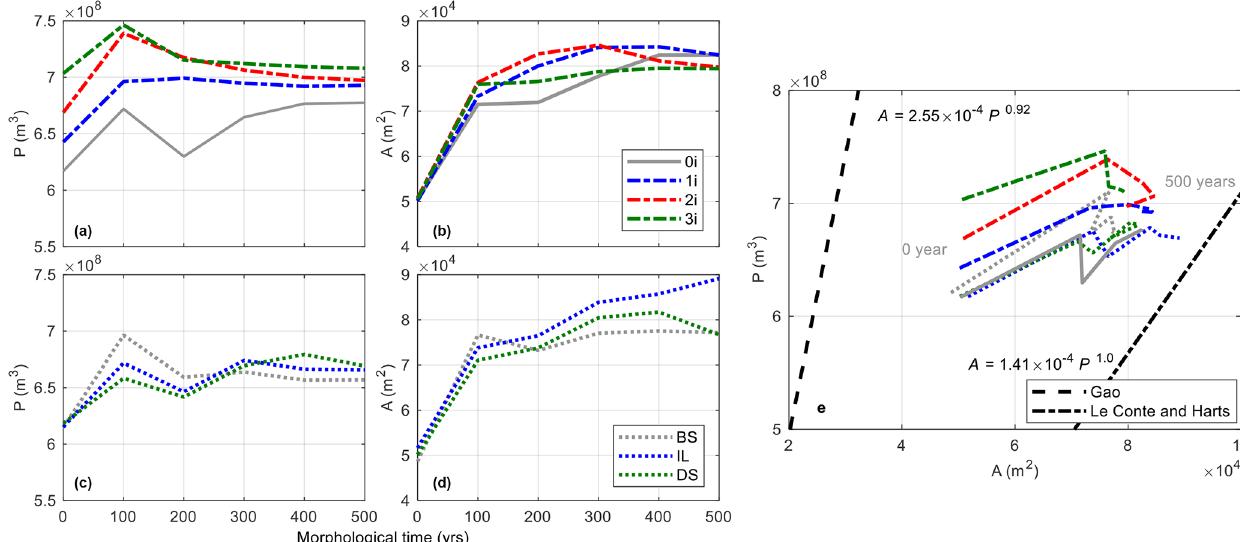
Figure 10. The evolution of tidal prism, inlet cross-sectional area and P – A relation for the different mouth island scenarios over 500 years. Panels (a, b) show the scenarios of different mouth island numbers: (c, d) show the scenarios of different mouth island locations.